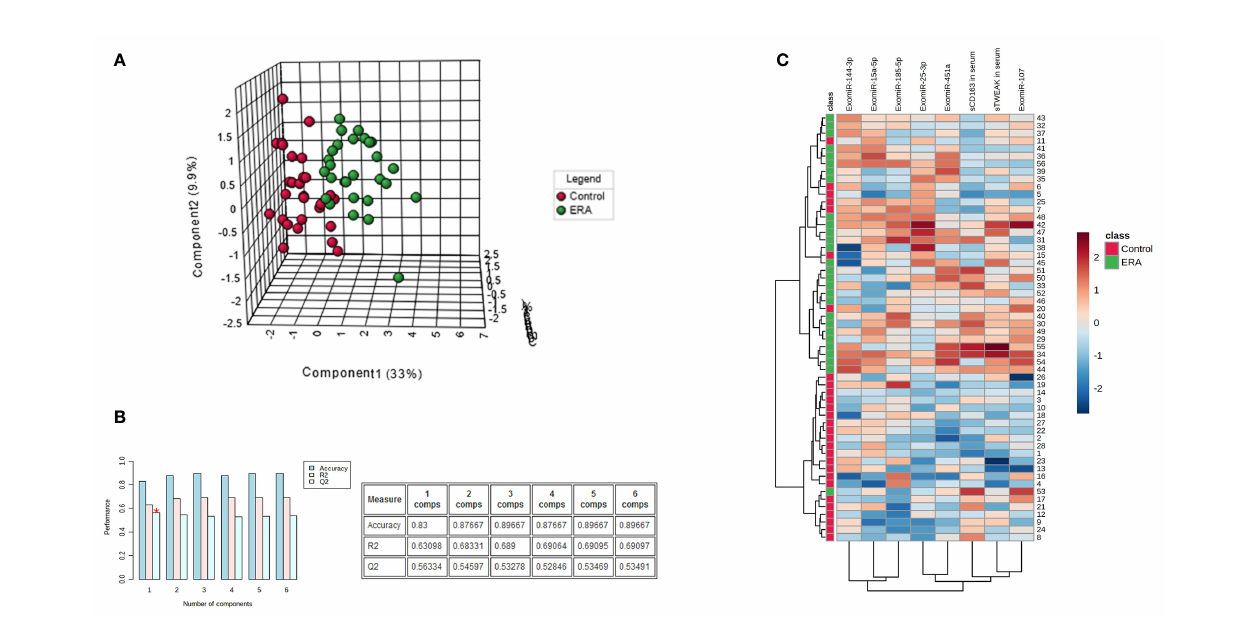
FIGURE 4 | Serum biomarker signature panel identi fi es early RA. (A) PLS-DA analysis of the most representative exomiRNAs (exomiR-144-3p, exomiR-25-3p, exomiR-15a-5p, exomiR-451a, exomiR-107, exomiR-185-5p) and serum cytokine levels of sTWEAK and sCD163 demonstrate that two groups early RA and controls can be separated. (B) Model accuracy. (C) Heap map analysis of early RA samples and controls show discrimination between cohorts and different abundance of each speci fi c